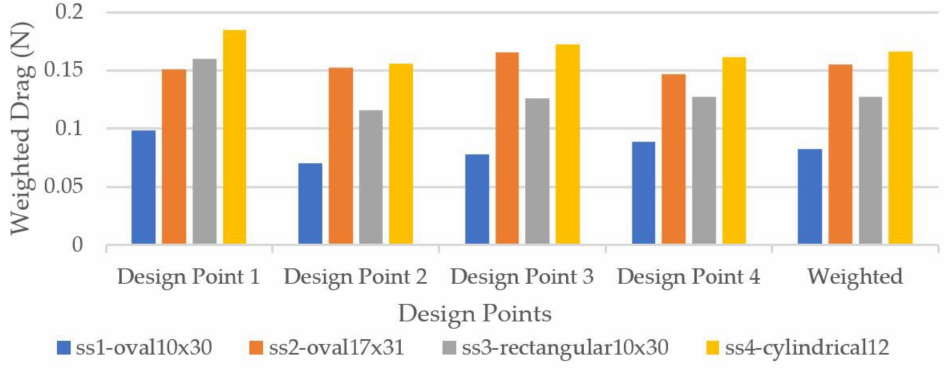
Figure 29. Weighted drag force on seat stay